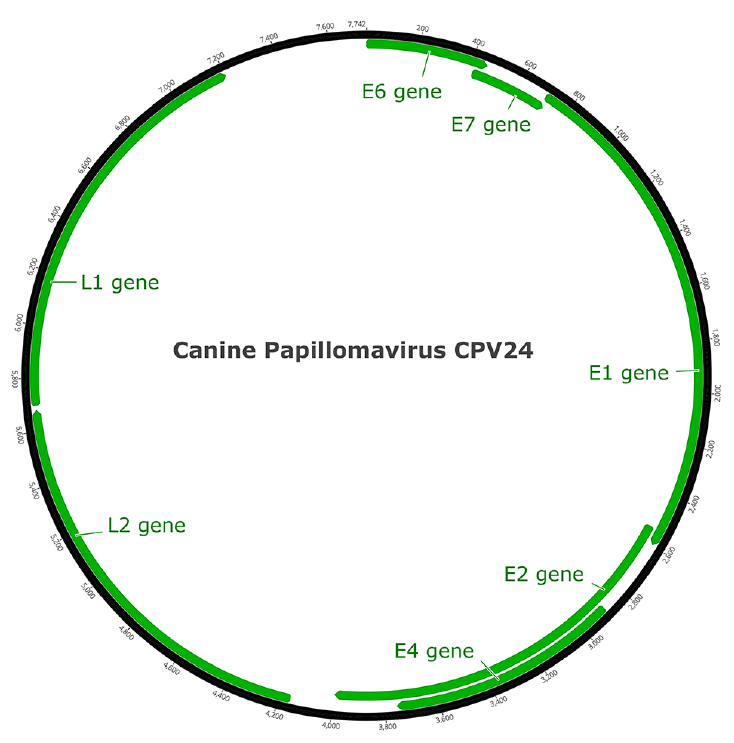
Figure 2. Schematic genomic organization of CPV24. Table 1. Predicted ORFs in the CPV24 genome. pI indicates the isoelectric